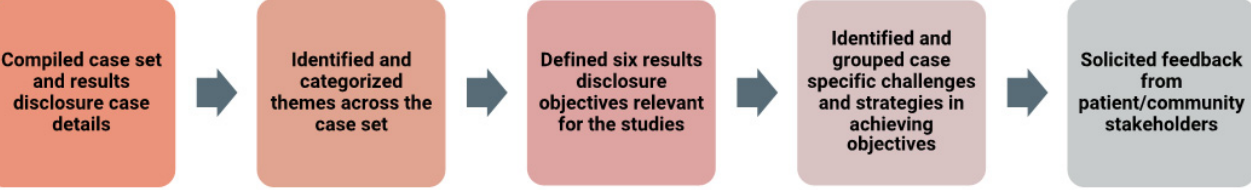
Figure 1. Project workflow. This project occurred in five stages: (1) compiling a case set, (2) identifying themes across the case set, (3) defining results disclosure objectives that were related to the Clinical Sequencing Evidence-Generating Research (CSER) projects, (4) identifying challenges and strategies in achieving the results disclosure objectives, and 5) soliciting feedback from CSER patient/community stakeholders.